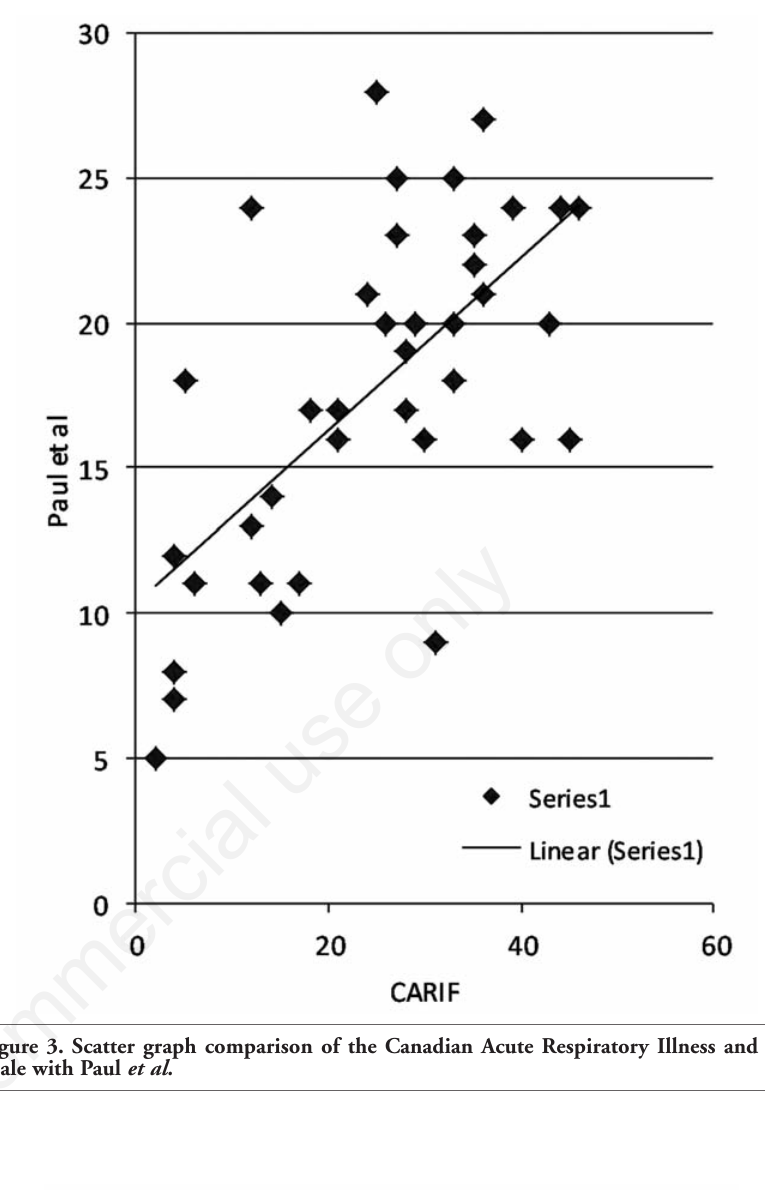
Figure 3. Scatter graph comparison of the Canadian Acute Respiratory Illness and Flu Scale with Paul et al.